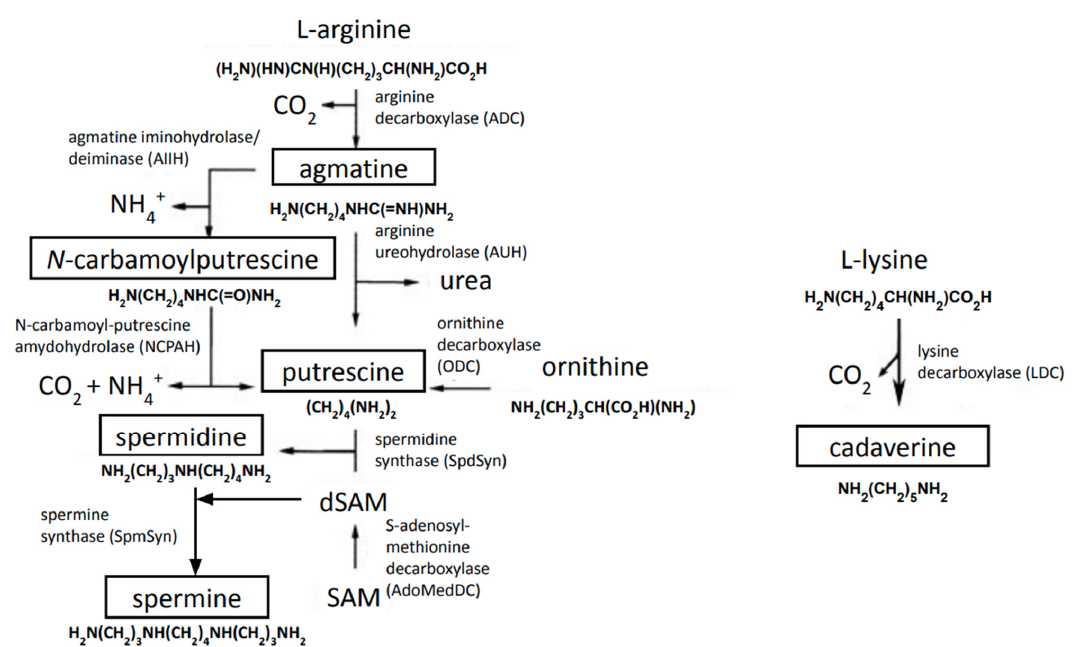
Figure 2. Combined polyamine biosynthetic pathways in bacteria. Enzymes that catalyze central reactions of polyamine biosynthesis as well as substrates and products of reactions are shown. Both ODC and ADC pathways and also LDC-dependent cadaverine production are depicted. Polyamine products are marked in boxes. SAM: S-adenosylmethionine; dSAM: decarboxylated S-adenosylmethionine [14,117].